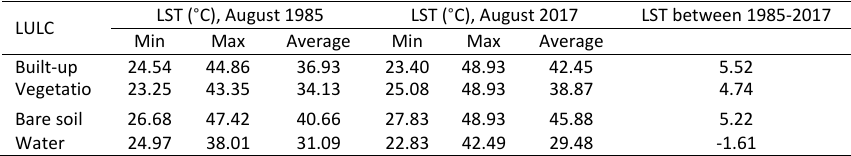
Table 3: Land surface temperature distribu (cid:415) on over LULC classes between 1985 and 2017 in Isfahan Table 3. Land surface temperature distribution over LULC classes between 1985 and 2017 in LST (°C), August 1985 LULC Max Average Average Built-up